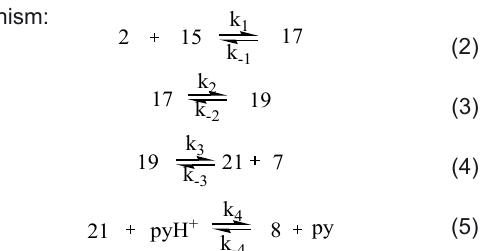
Figure 4. The potential energy profile for the channel 2 in reaction III computed with B3LYP/6-31G(d)//B3LYP/6-311++G(d,p) method. Solid and dashed lines represent free energies ) and ZPE corrected energies ( ∆ E ( ∆ G 298 reactants, respectively.